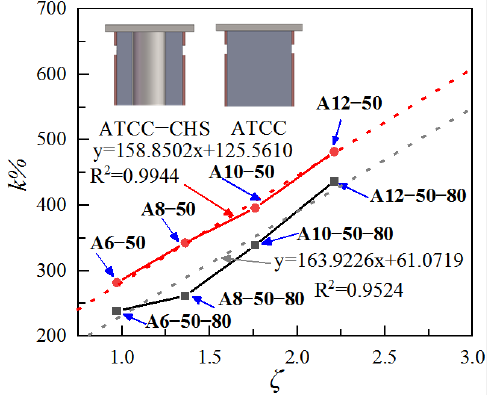
Figure 8. k –ζ relationship. Figure 8. k – ζ